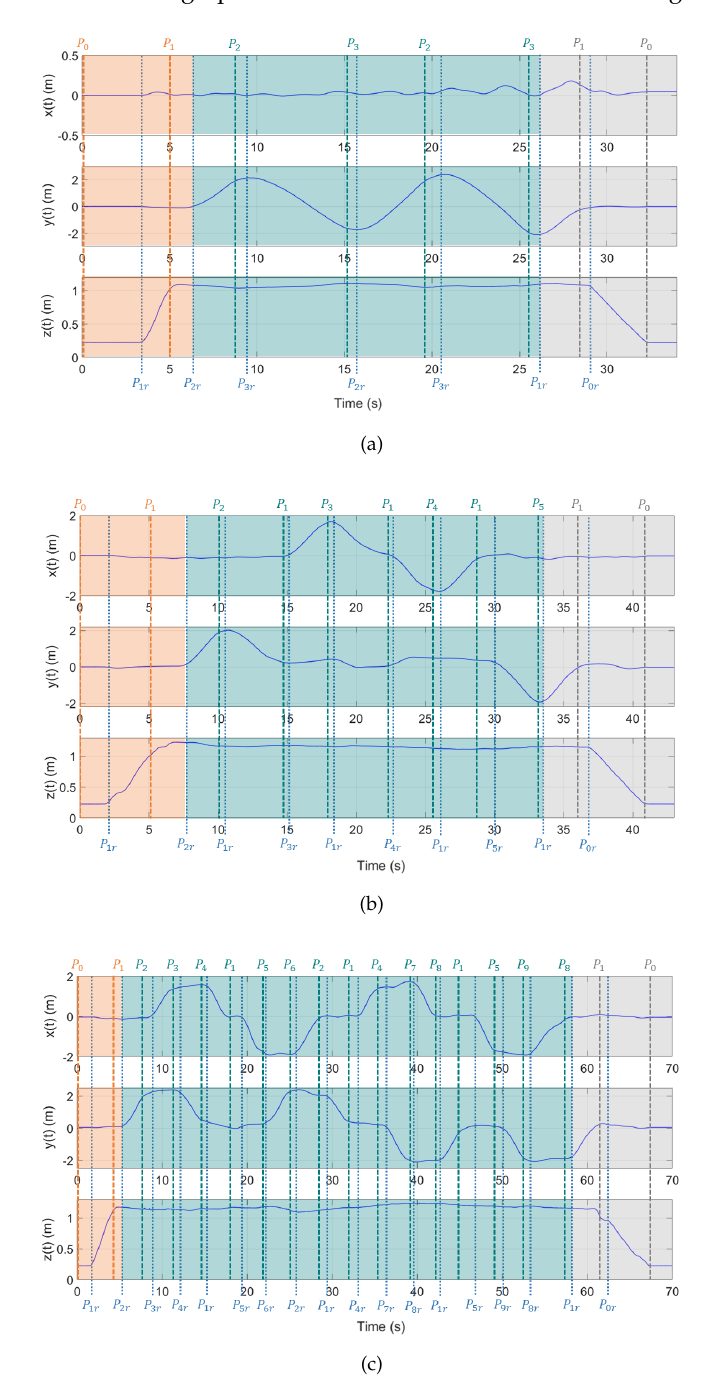
Figure 12. Graphic-level results. ( a ) Graphic-level results of the 1st movement. ( b ) Graphic-level results of the 2nd movement. ( c ) Graphic-level results of the 3rd